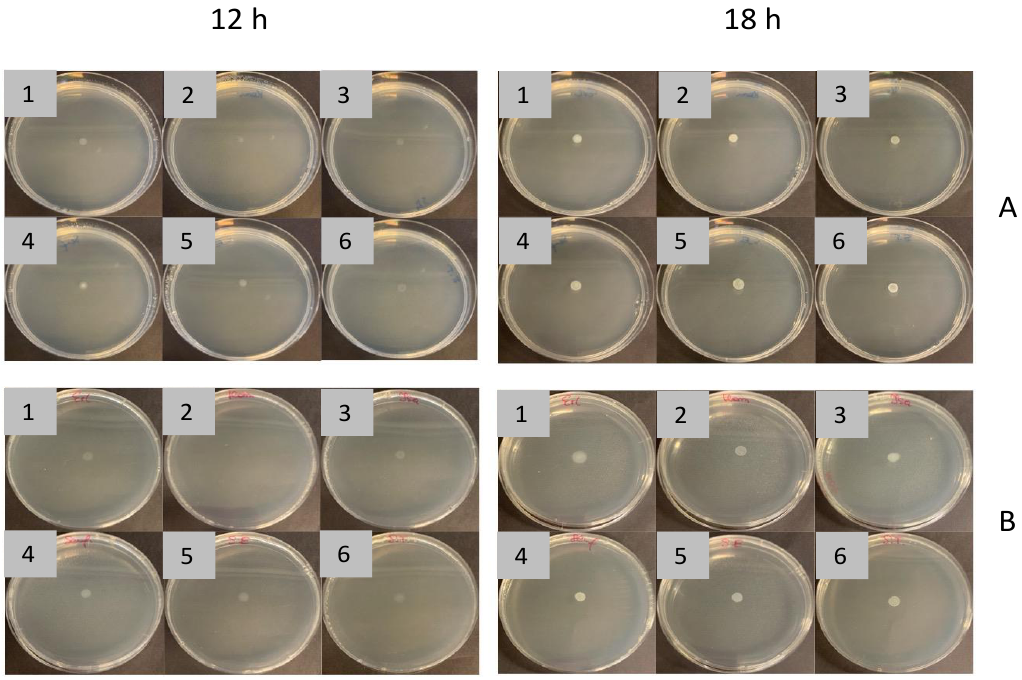
Figure 7. Swarming motility assay. Definitions of abbreviations: ( A )— Salmonella strains not passaged in SPPP, ( B )— Salmonella strains passaged eight times in 50% SPPP; 1— S . Erlangen, 2— S . Hammonia, 3 — S . Isaszeg, 4 — S. Senftenberg, 5 — S. Enteritidis ATCC 13076, 6 — S . Typhimurium